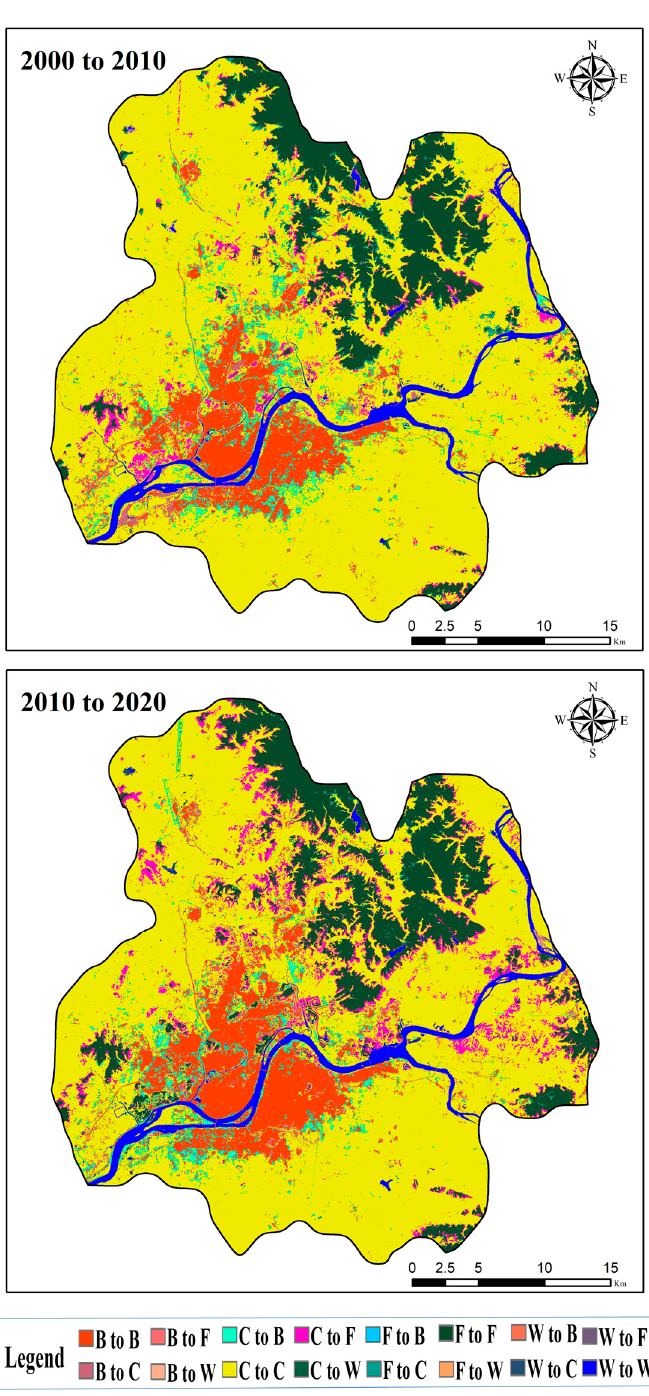
Figure 6. Spatial transformation maps for 2000–2010 and 2010–2020. B: built-up; C: cropland; F: forest; and W: waterbodies.